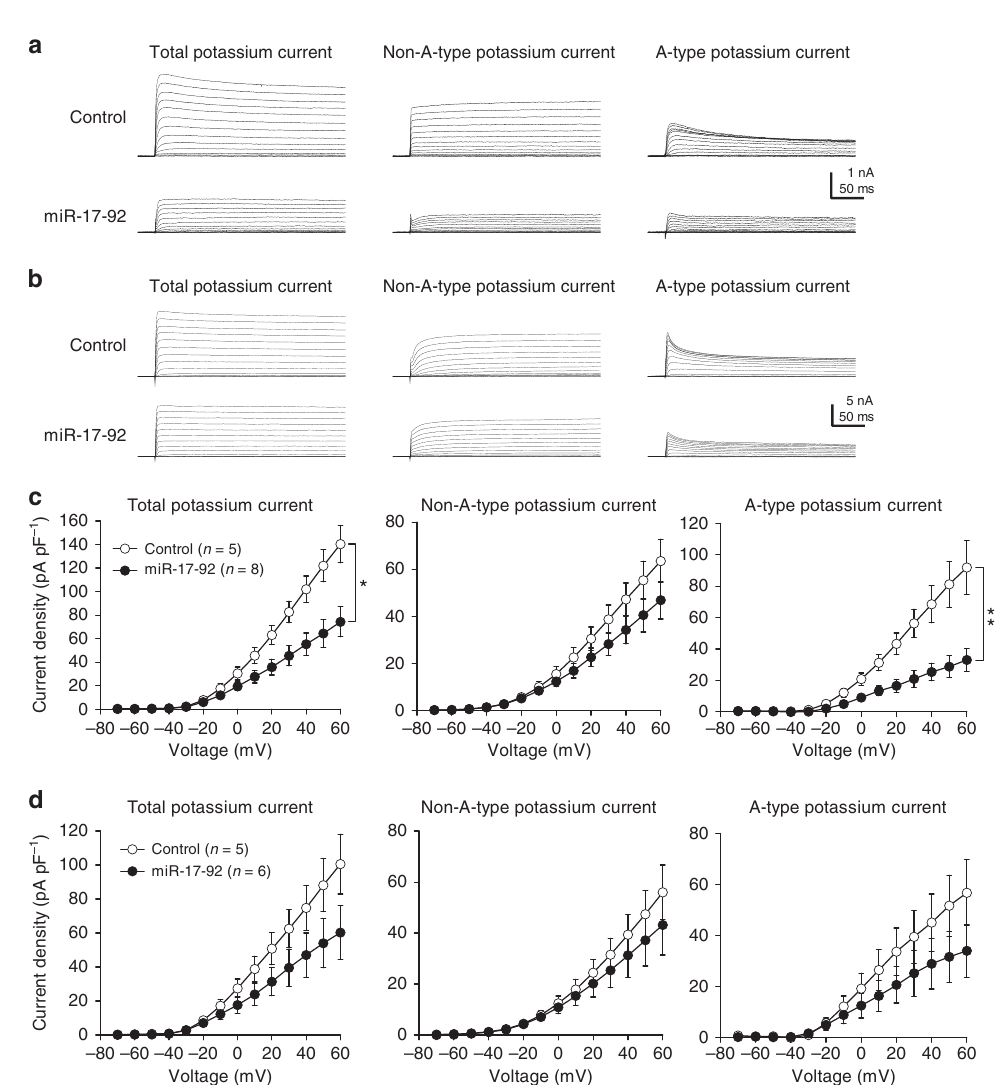
Figure 6 | miR-17-92 reduces potassium currents in DRG neurons. Potassium currents were recorded in acutely-dissociated DRG neurons 7 days after control or miR-17-92 AAV vector injection. Only EGFP-fluorescent DRG neurons were recorded. ( a , b ) Representative traces of total, non-A-type and A-type potassium currents elicited by stepwise depolarization from (cid:2) 70 to 60mV at holding potential of (cid:2) 80mV in small ( a ) and medium/large ( b ) DRG neurons. ( c , d ) Current density of each potassium current component plotted against voltage in small ( c ) and medium/large ( d ) DRG neurons obtained from three rats. Error bars are s.e.m. * P ¼ 0.016 and ** P ¼ 0.003, two-way repeated-measures